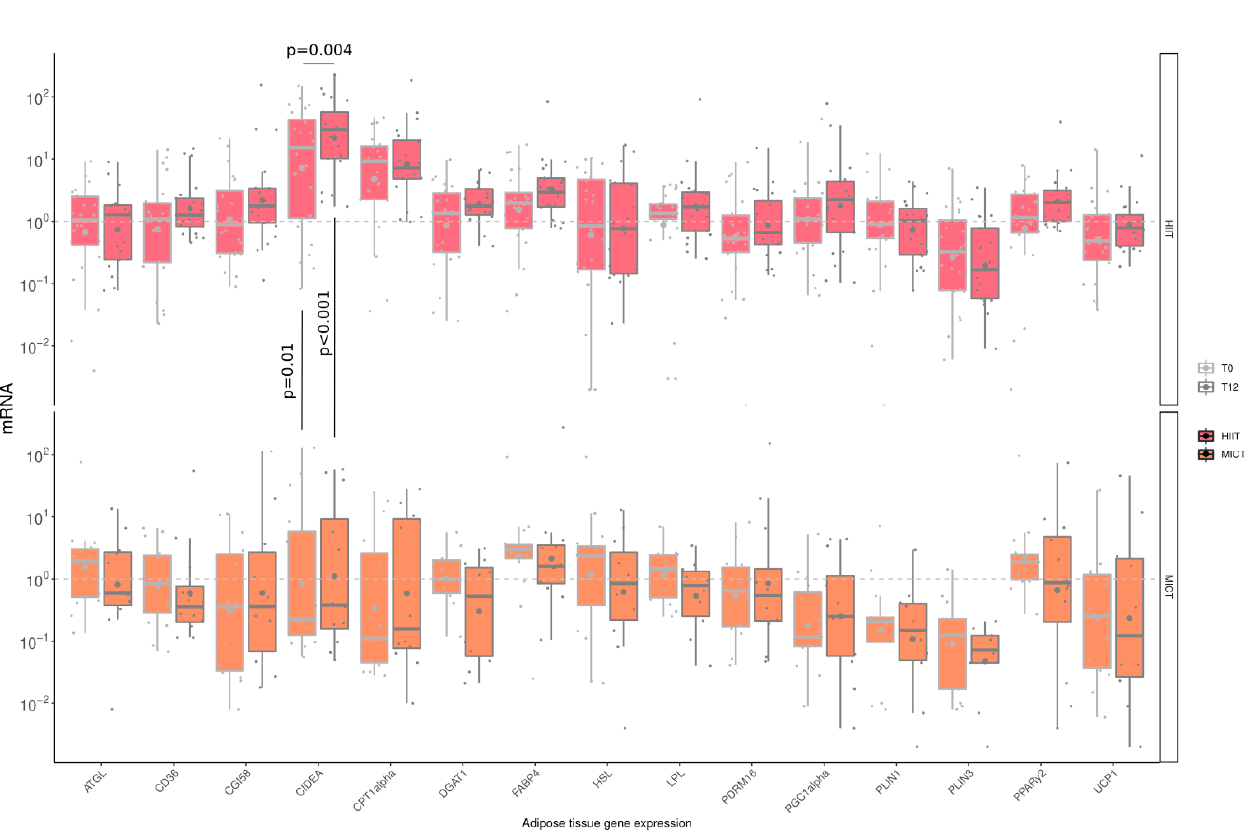
Figure 5. Impact of HIIT and MICT on adipose tissue mRNA gene expression. HIIT = High-Intensity Interval Training (pink), MICT = Moderate-Intensity Continuous Training (orange), T0 = before the 12-week intervention (light grey), T12 = after the 12-week intervention (dark grey), each dot represents a subject, the grey point the mean, and the grey line in the boxplot the median, ATGL = adipose triglyceride lipase; CD36 = cluster of differentiation 36; CGI58 = comparative gene identification- 58; CIDEA = cell death-inducing DFFA-like effector a; CPT1- α Carnityl PalmitolylTransferase-1 α